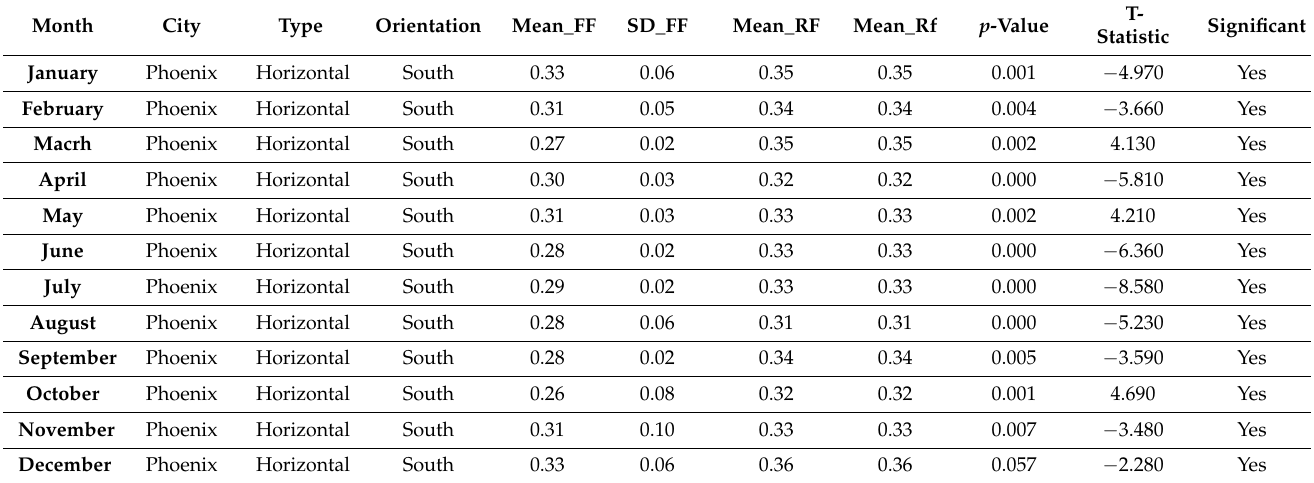
Table 12. Significant differences between fixed facade (FF) and responsive facade (RF) with horizontal louvers.